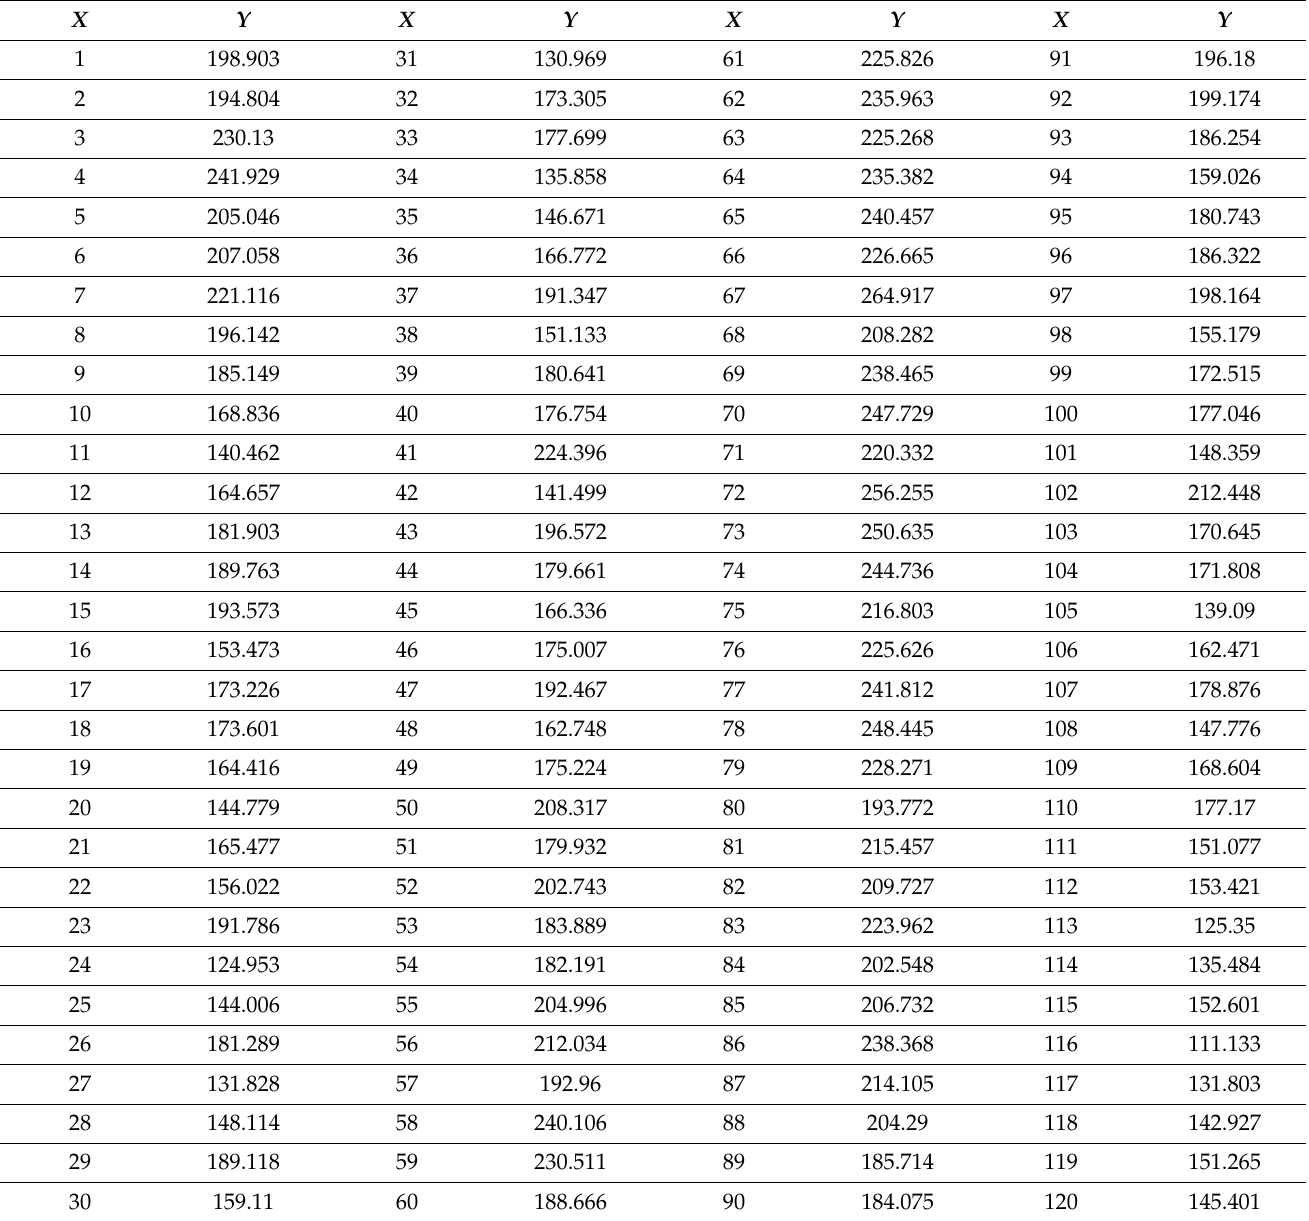
Table 2. Example of obtained